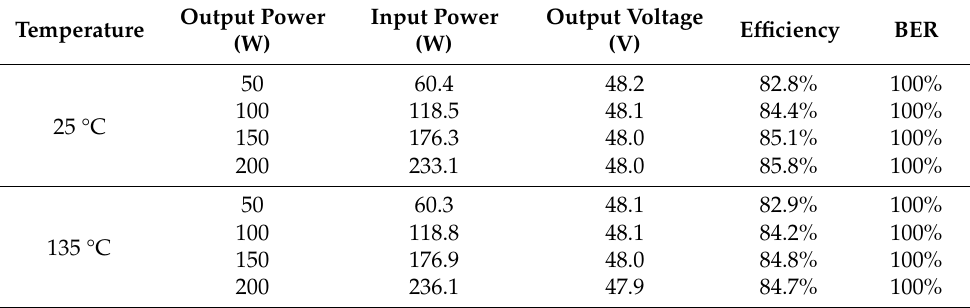
Table 3. System experimental